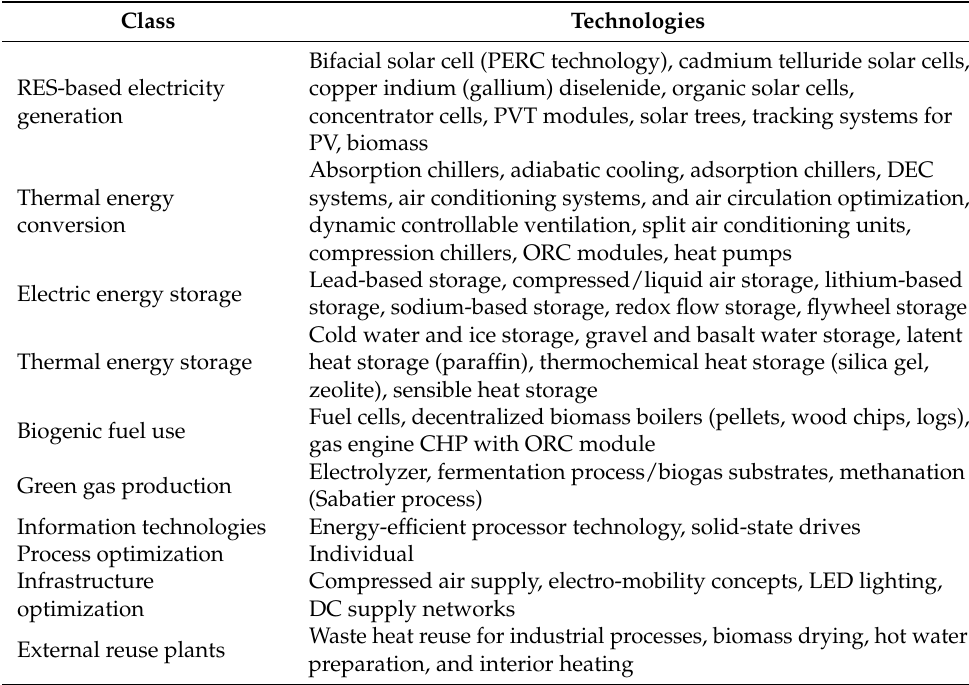
Table 3. Portfolio